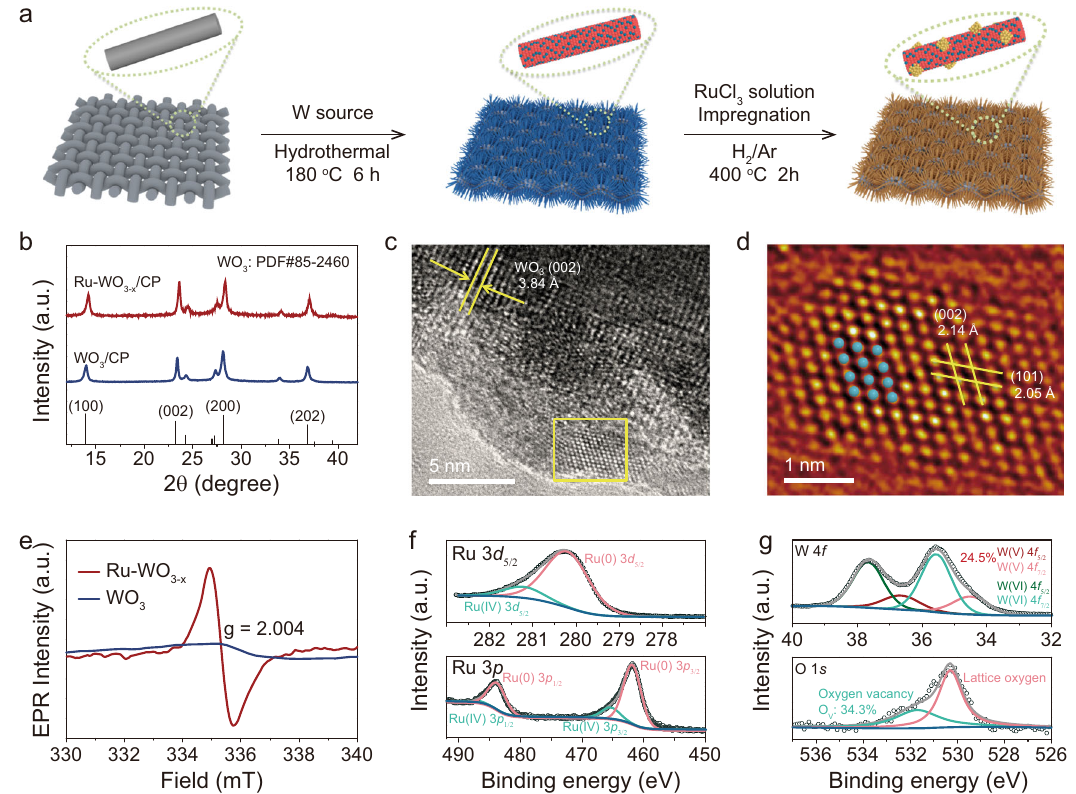
c ofRu-WO 3 − x /CP.The blue spheresrepresent Ruatoms. e EPR spectraofWO 3 and Ru-WO 3 − x . f Ru 3 d 5/2 and Ru 3 p XPS spectra of Ru-WO 3 − x /CP. g W 4 f and O 1 s XPS spectra of Ru-WO 3 − x